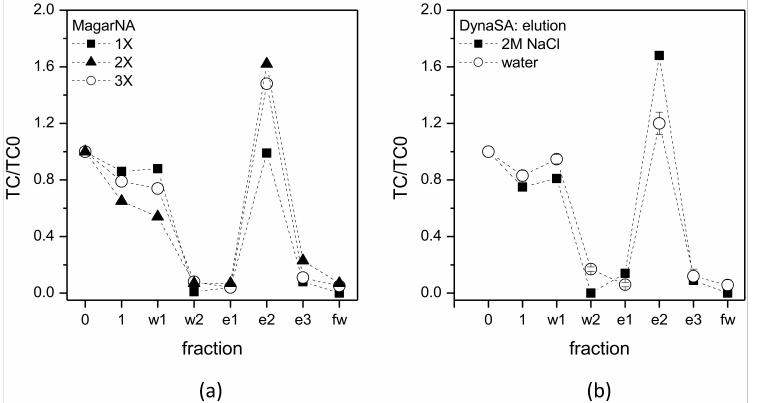
Figure 7. Microfluidic test. MagarNA beads ( a ) or DynaSA beads ( b ) were functionalized with a-TCmu aptamer and inserted in a 100 µL chip chamber before fluxing TC at 0.1 ng/µL concentration (fraction named 0). Consecutive fractions were collected and quantified with HPLC: fraction 1 represents unbound TC, fractions w1 and w2 are two successive washes, fractions e1-e3 represent eluted TC and fraction fw is the final wash. In ( a ) different amount of functionalized beads are tested, while in ( b ) different elution methods are shown, i.e., high ionic strength (2M NaCl) and high temperature (water at 75 °C).